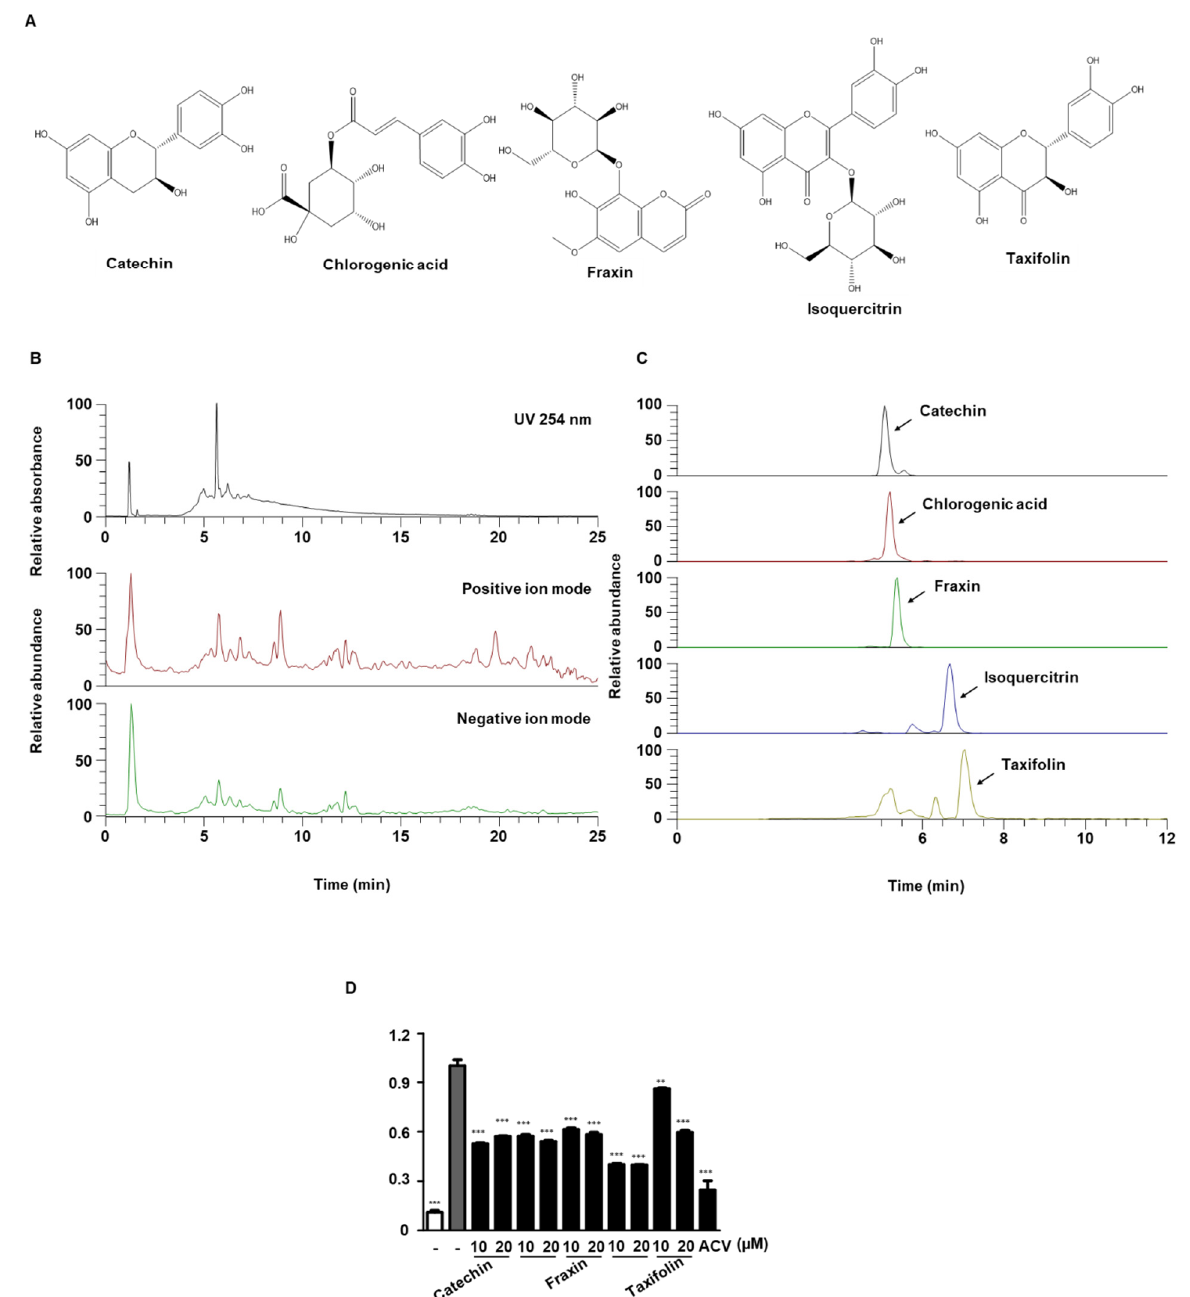
Figure 7. UPLC-DAD-MS/MS analysis of QA. ( A ) Single compound structure of QA. ( B ) UV chromatogram and TIC of QA, ( C ) EIC of the identified phytochemicals in QA. ( D ) SK-N-SH cells were infected with HSV GFP for 2 h and treated with five phytochemicals (10 and 20 µM) for 48 h. HSV GFP (MOI = 2) expression levels were analyzed by flow cytometry. The data are representative of three independent experiments and quantified as mean values ± SEM. One-way ANOVA with Tukey’s post hoc test; * p < 0.05, ** p < 0.01, *** p < 0.001, compared with the HSV-1 treatment.